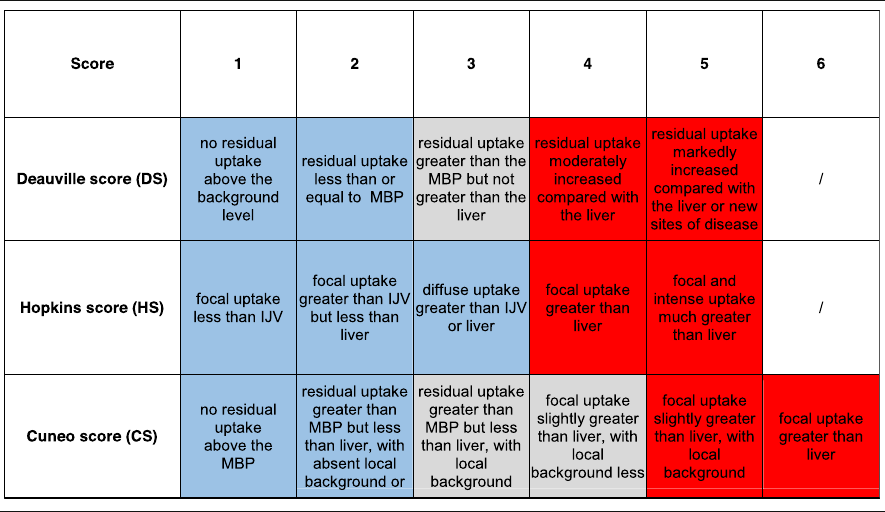
Table 1 Standardized reporting criteria used to assess FDG-PET/CT scans (Deauville, Hopkins, and Cuneo